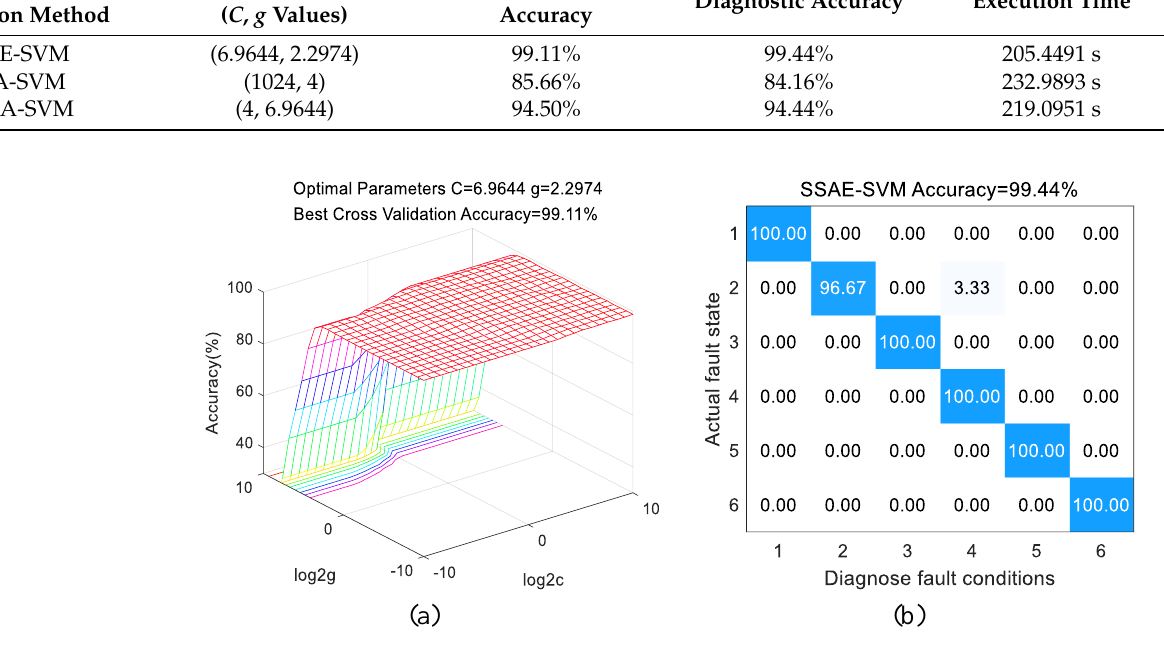
Figure 8. The SSAE dimension reduction method: ( a ) optimal parameters; ( b ) classification results.